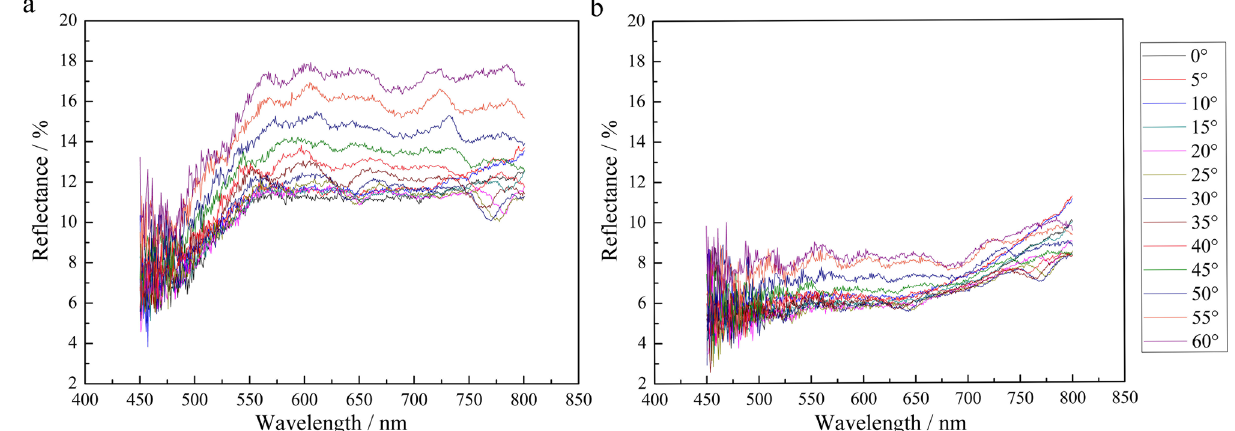
Figure 4. Measured light reflectance for D. tityus in the yellow-green dry state ( a ) and the deep-brown wet state ( b ) at incidence angles varying from 0° to 60° with an angular interval of